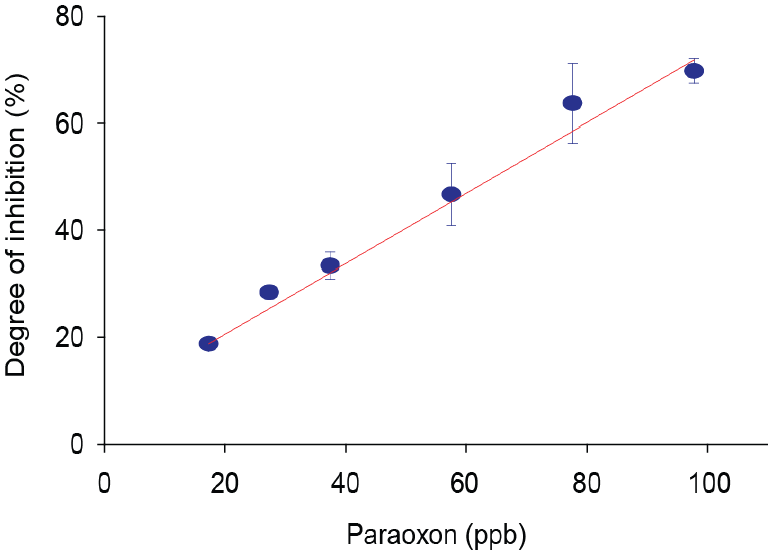
Figure 4. Olive oil matrix effect. Inhibition percentage of the current signal recorded in the presence of different concentrations of paraoxon in olive oil extracted with QuEChERS.